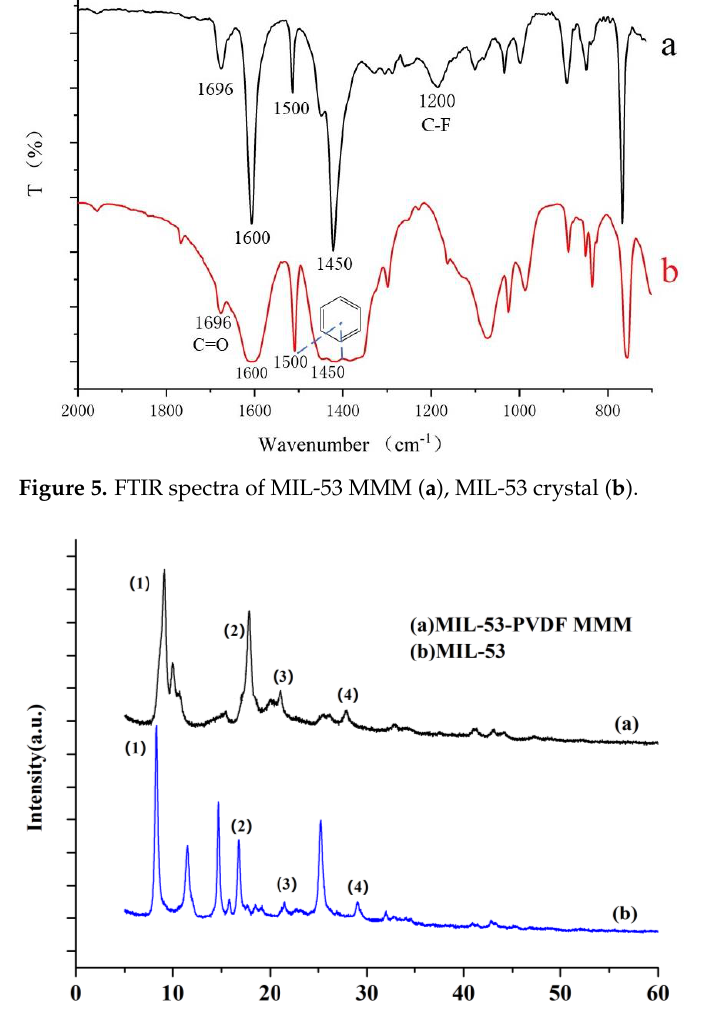
Figure 6. XRD patterns of MIL-53 MMM ( a ), MIL-53 crystal ( b